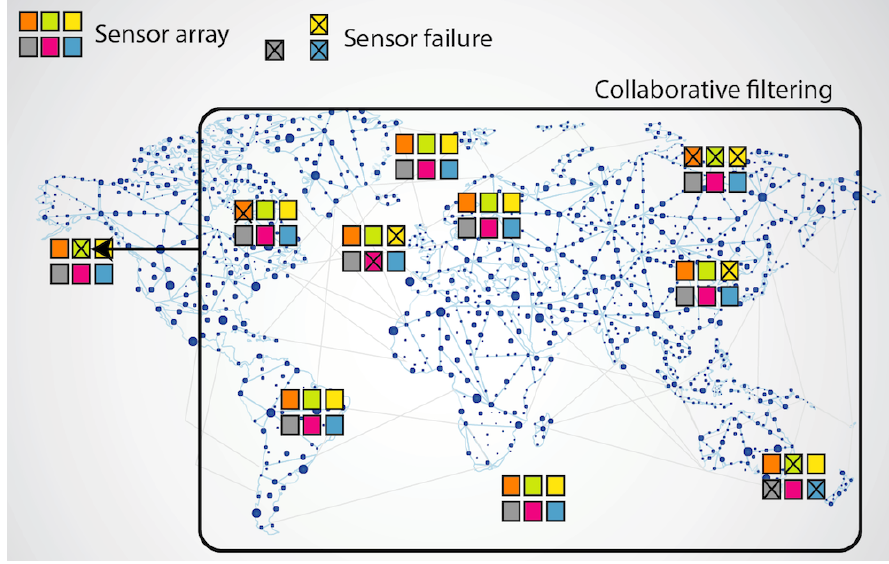
Figure 1. Collaborative filtering approach to predict sensors failed